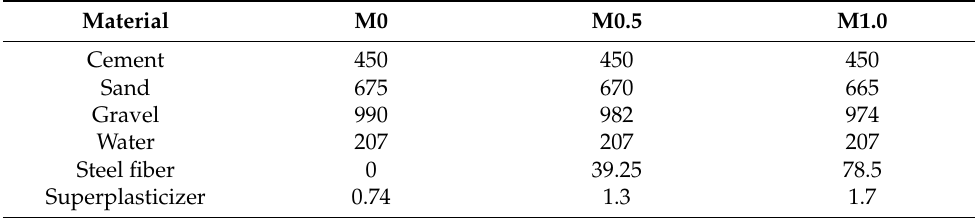
( b ) Figure 4. Impact and compressive strength specimens. ( a ) Specimen molds; ( b ) Cast specimens The 24 disks and 12 concrete cubes from each mixture were each divided into 4 groups of specimens. Three high temperature levels were adopted in this study: 200, 400, and 600 °C. Six disk specimens and three cube specimens from each mixture were subjected to each level of high-temperature exposure. The fourth group of specimens (6 disks and 3 cubes) from each mixture were tested at room temperature without being subjected to high temperatures. Thus, in total, 96 disks and 48 cubes were prepared and tested to evaluate the residual impact and compressive strength of the adopted mixtures. After removal from the water curing tank, the specimens were left in the laboratory environment until the next morning, when a primary drying phase was conducted using an electrical oven. The specimens were placed in the oven for 24 h at a temperature of 105 °C to prevent unfavorable explosive failure while being heated to high temperatures. The heating to the desired high temperatures was conducted at an approximate constant rate of 4 °C/min using the electrical high-temperature furnace shown in Figure 5a. The specimens were placed inside a protection box in the furnace to avoid damaging the furnace interior elements in the case of specimen explosive failure, as shown in Figure 5b. The specimens were heated in small groups of six disks or three cubes to allow for uniform temperature distribution over the specimen surfaces. Each of the temperature levels was reached by considering the above-mentioned heating rate. When the desired